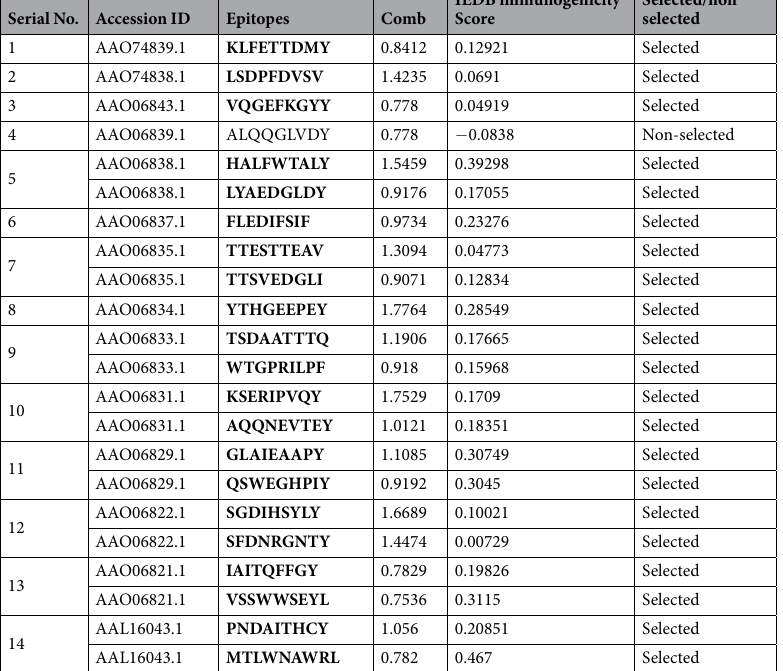
Table 1. Predicted cytotoxic T-lymphocyte (CTL) specific epitopes and their immunogenicity score obtained from the immune epitope database.